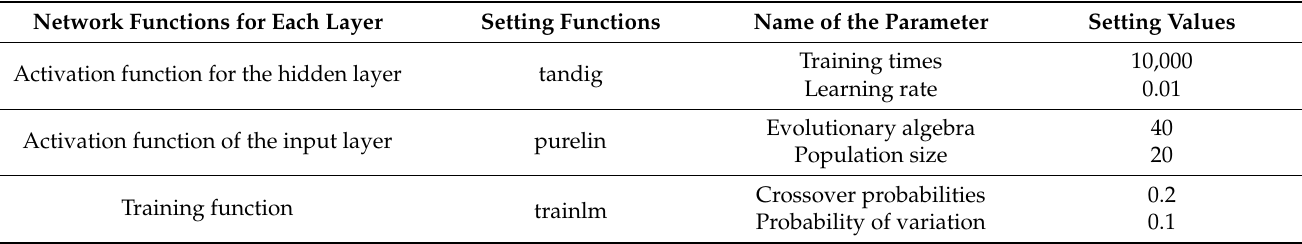
Table 3. Network functions and training parameters for the respective layer of the GA-BP model.